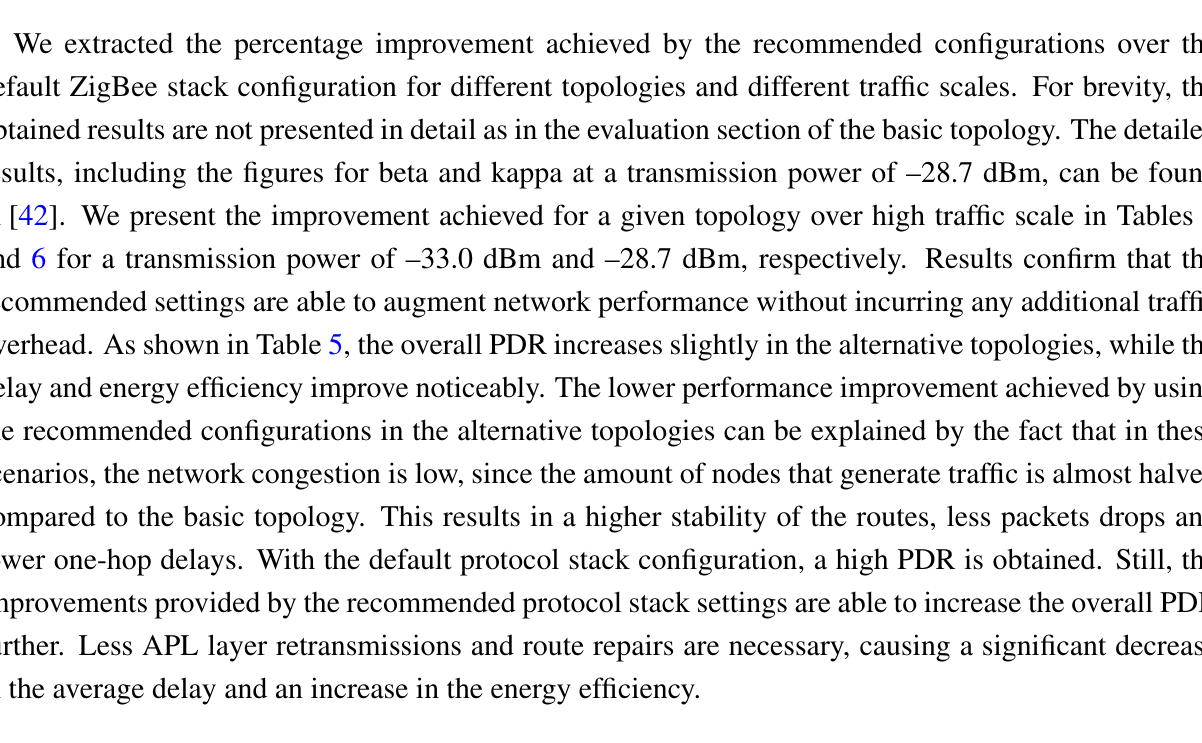
( a ) Dumbbell and ( b ) square topologies, with roles as defined for